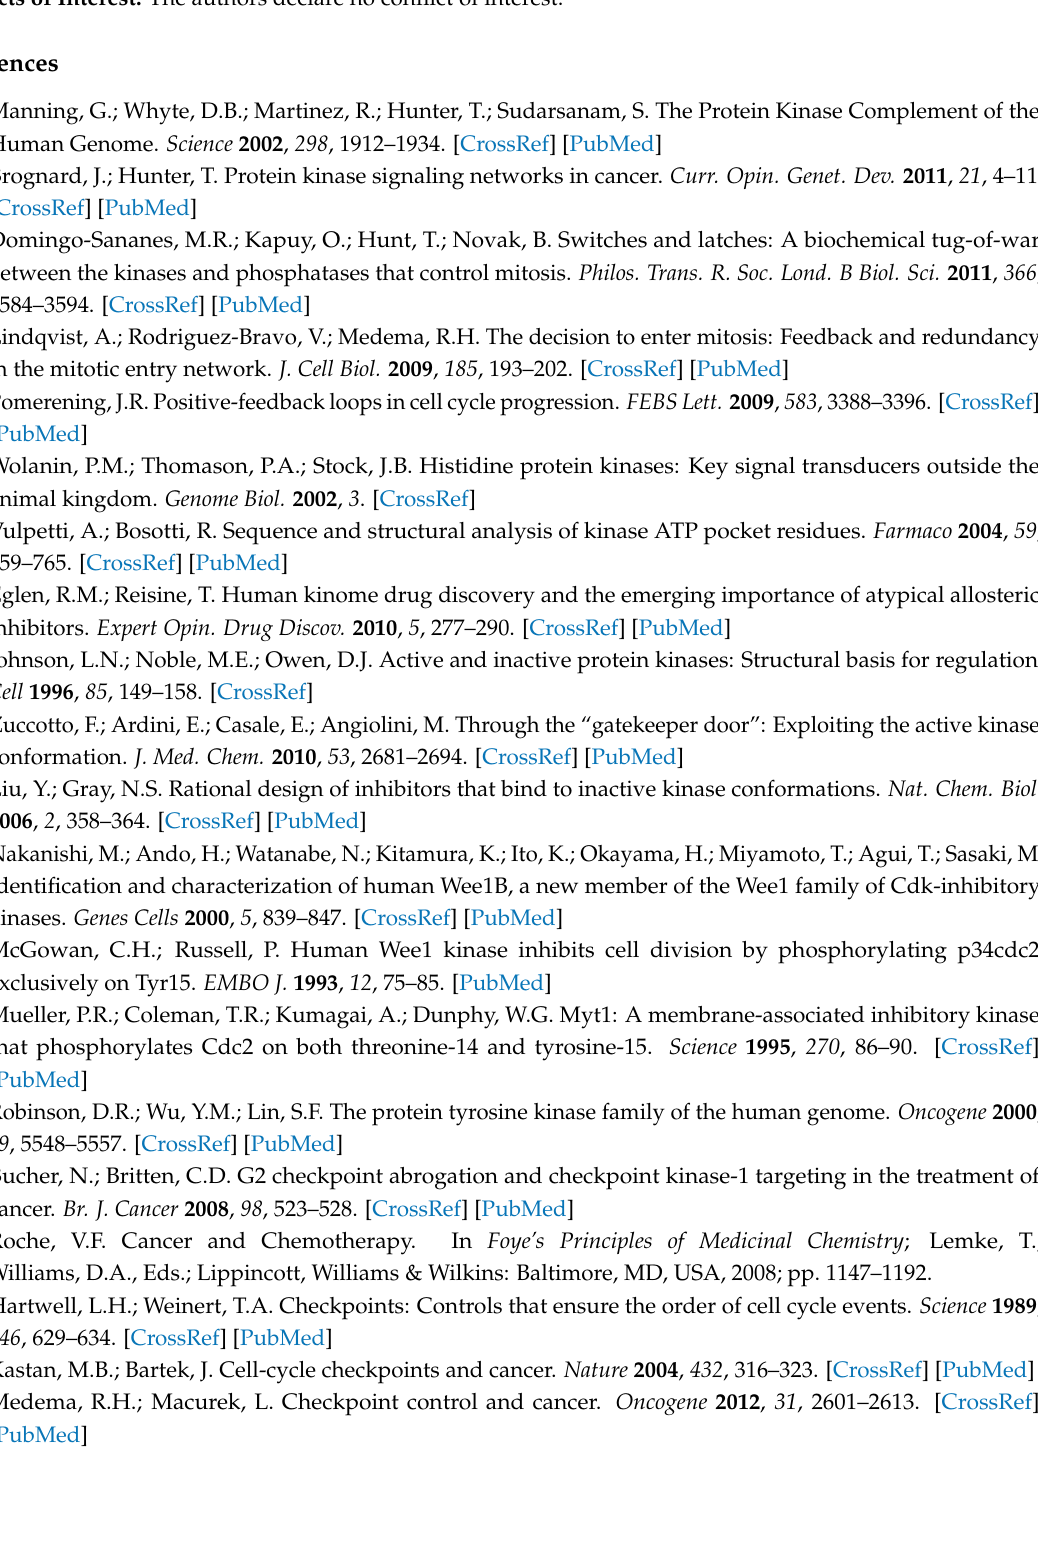
Supplementary Materials: Supplementary materials are available online. Table S1: Clinical trials